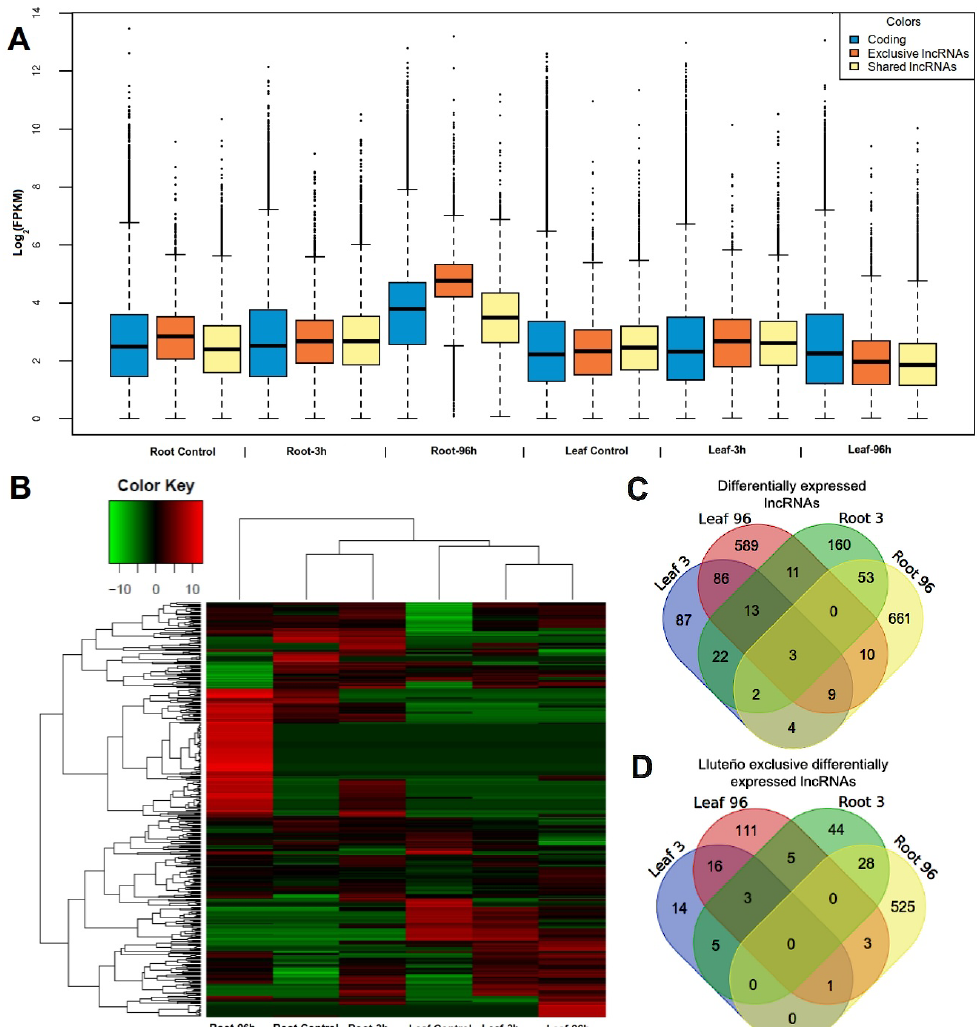
Figure 5. Differentially expressed lncRNAs in Lluteño maize. ( A ) Comparison of expression values log 2 fragments per kilobase million (log 2 FPKM) between each condition. Blue boxes are coding genes, orange boxes are Lluteño exclusive lncRNAs and light yellow are the lncRNAs shared with other Z. mays hybrids. The boxes represent 50% of the expressed transcripts, while dots above and below the boxes represents the other 25% of the transcripts with higher and smaller expression levels, respectively. The boxes size represents the expression levels variability of the transcripts. A cutoff of 1 FPKM was used to define if a transcript is expressed or not; ( B ) Heat map representation in logarithmic scale of library mean normalized read counts of differentially expressed lncRNAs (fold change higher than four); ( C , D ) Venn diagrams of the comparison between differentially expressed lncRNAs in each time condition, all lncRNAs and Lluteño exclusive lncRNAs respectively. All conditions were compared against its same tissue at 0 h (control) of salt and boron